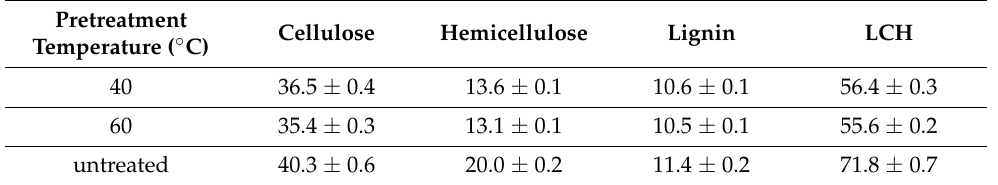
Table 4. Changes of main compositions after pretreatment *.